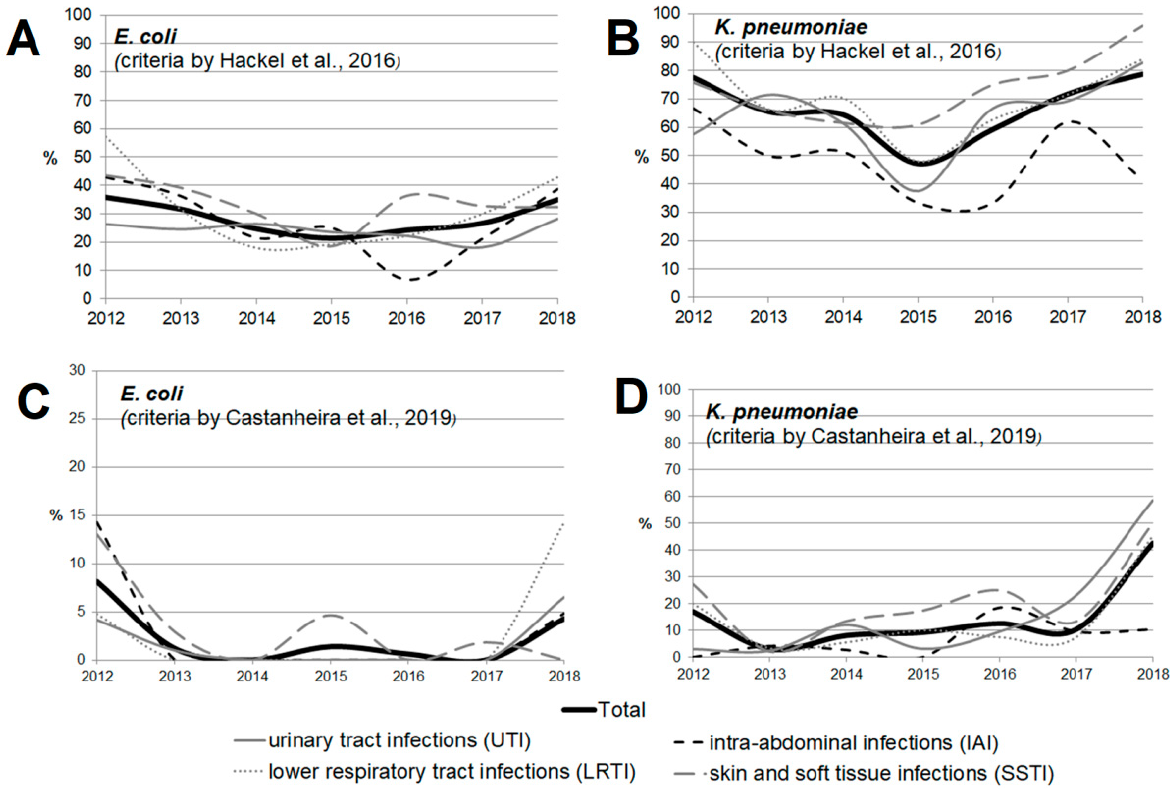
Figure 4. The dynamics of the percentage of multidrug-resistant strains among E. coli ( A , C ) and K. pneumoniae ( B , D ) isolates depending on location of the infection source according to the criteria proposed by Hackel et al. [14] ( A , B ) and Castanheira et al. [15] ( C , D ).